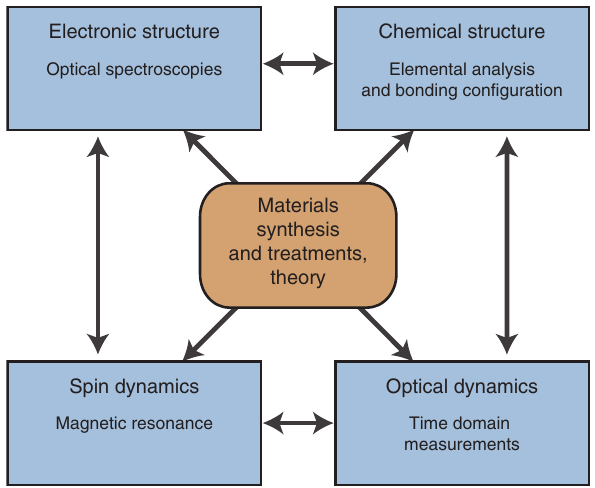
Figure 4: Identification and characterization of new QPDs